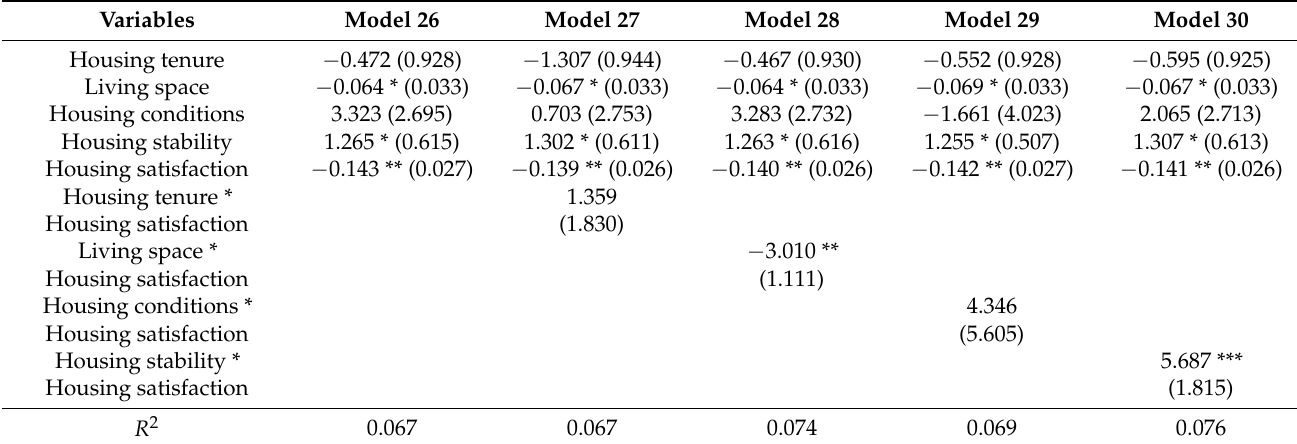
Table 8. The moderating effects of subjective housing status on the relationship between objective housing status and